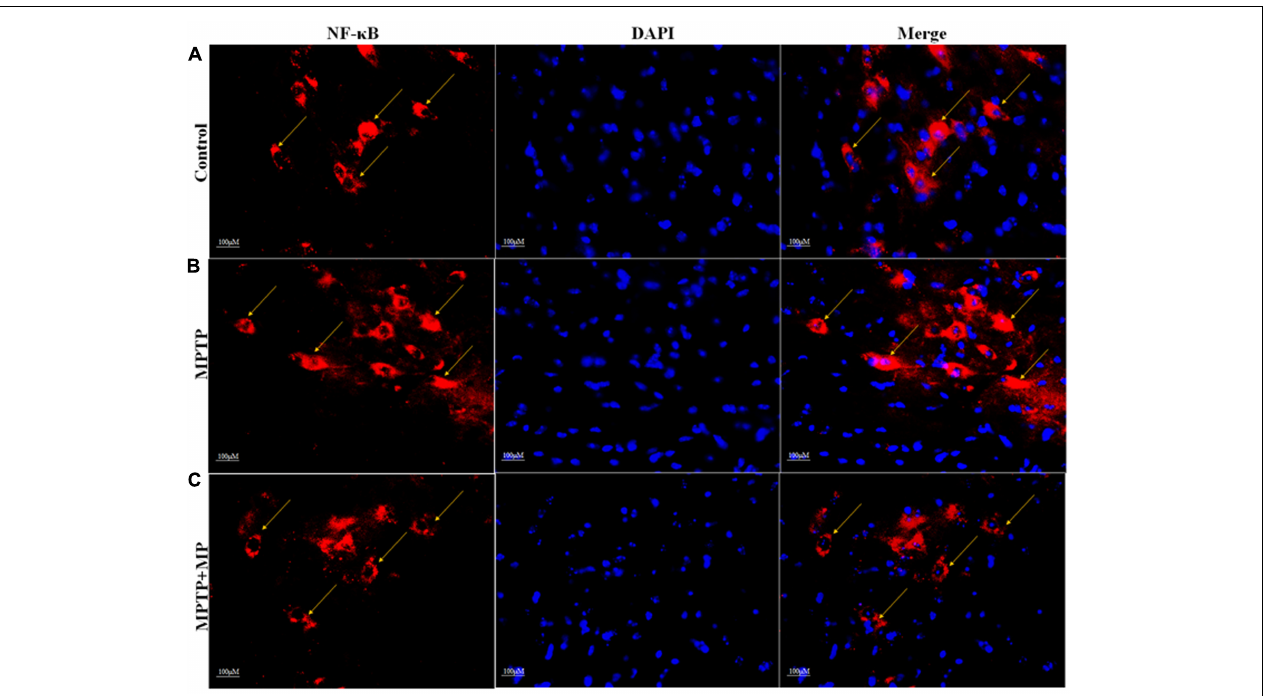
FIGURE 6 | Effect of Mp on the nuclear translocation of NF- κ B in SNpc with 40x magnifications after staining. In substantia nigra (SN) as compared to control group (A) , nuclear translocation of NF- κ B positive cells were increased in MPTP treated group (B) while Mp treatment inhibits this nuclear translocation of NF- κ B (C)